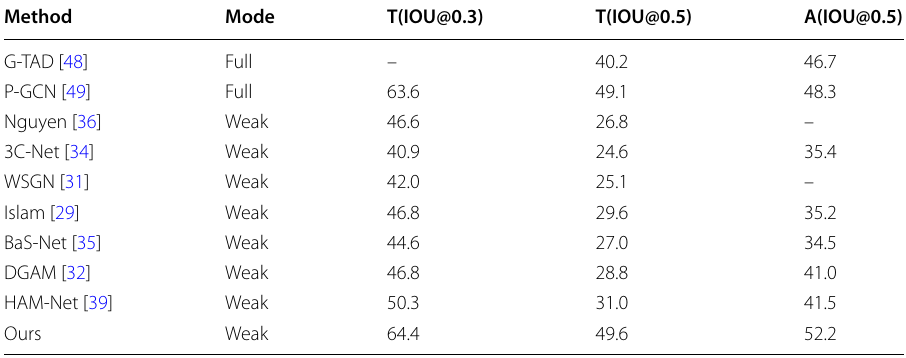
Table 5 Temporal action localization